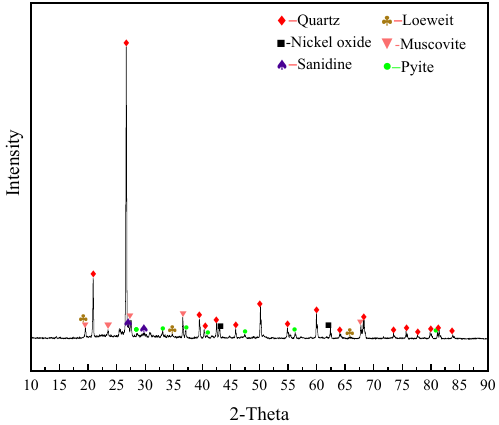
Figure 2. XRD pattern of the stone coal raw ore.